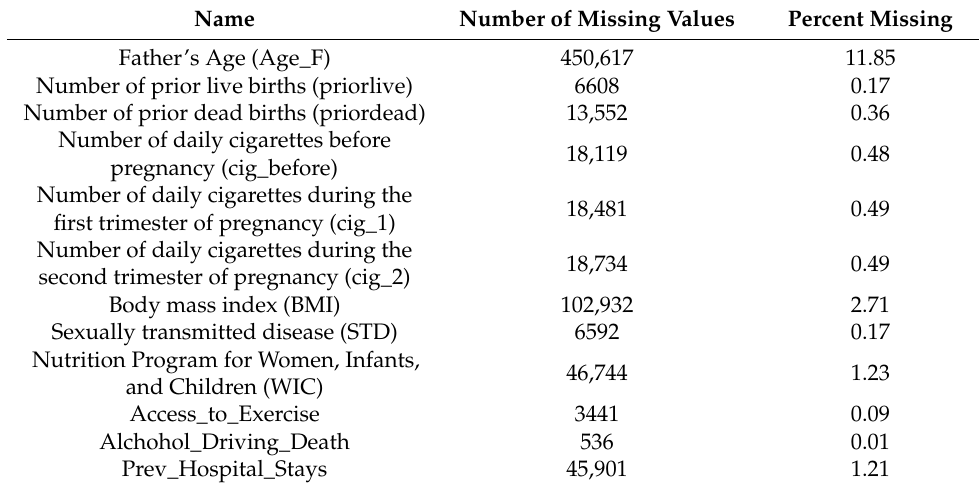
Table 1. The number of missing values in the